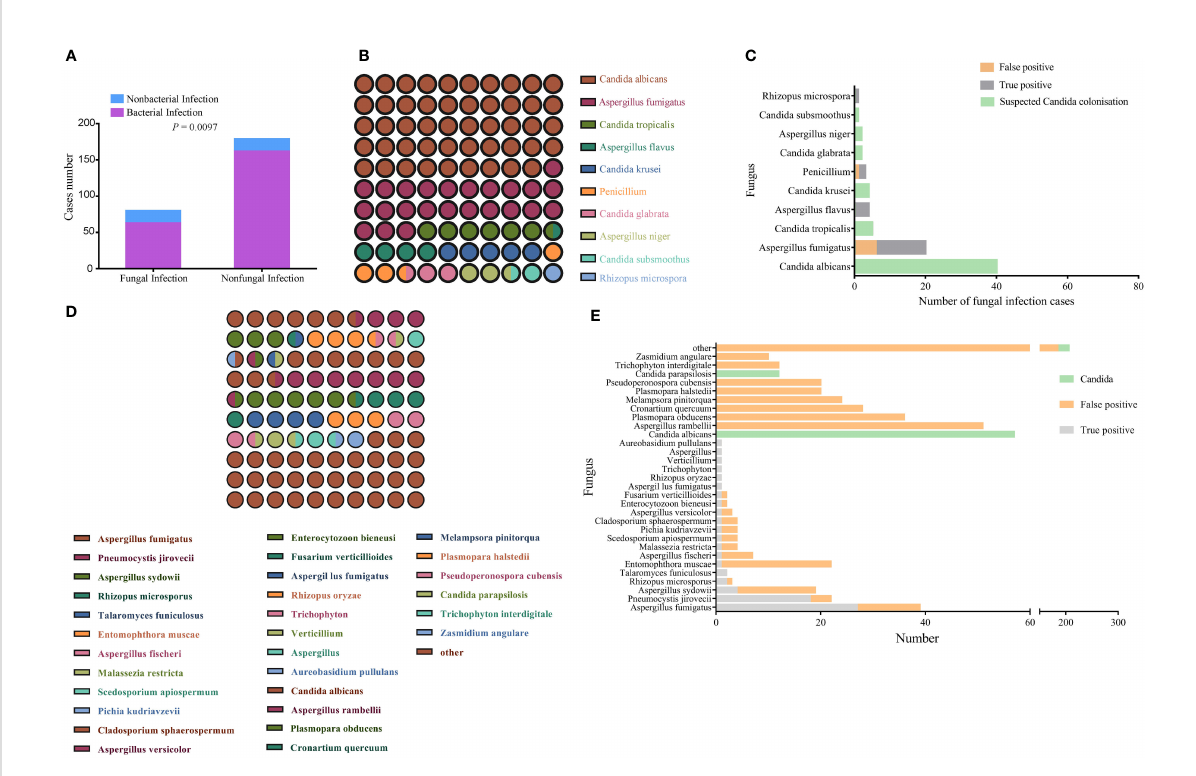
FIGURE 2 Identi fi cation of pathogenic fungi by conventional culture methods and mNGS. (A) Bacterial infection status of the fungal infection and non- fungal infection groups. The comparison between the two groups was made using the Pearson chi-squared ( c 2) test. P < 0.05 indicates a signi fi cant difference. (B) Matrix of fungal species detected the culture method; the number of points represents species detection frequency. (C) Pro fi le of fungal species detected by the culture method that distinguishes between colonization, false positives, and true positives. (D) Matrix of fungal species detected by mNGS; the number of points represents detection frequency (species with frequencies <10 were all grouped together). (E) Pro fi le of fungal species detected by mNGS that distinguishes between colonization, false positives, and true positives; the number of points represents detection frequency (species with frequencies <10 were grouped other).